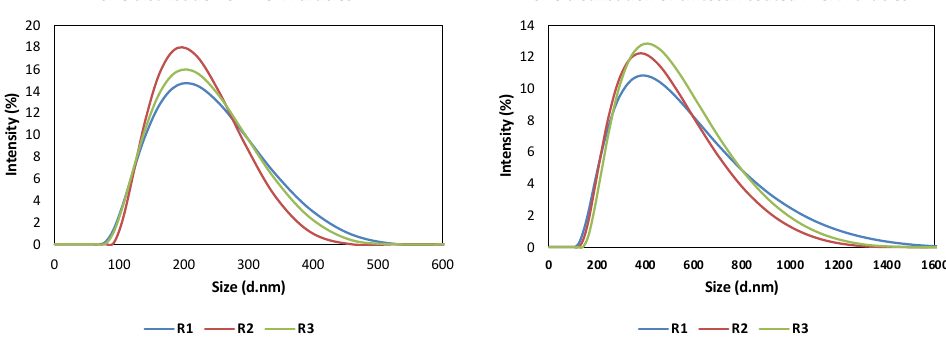
Figure 2. Size distribution by intensity of the uncoated PLGA and CS-PLGA particles. R1, R2, and R3 denote the replicates R1, R2, and R3, respectively.